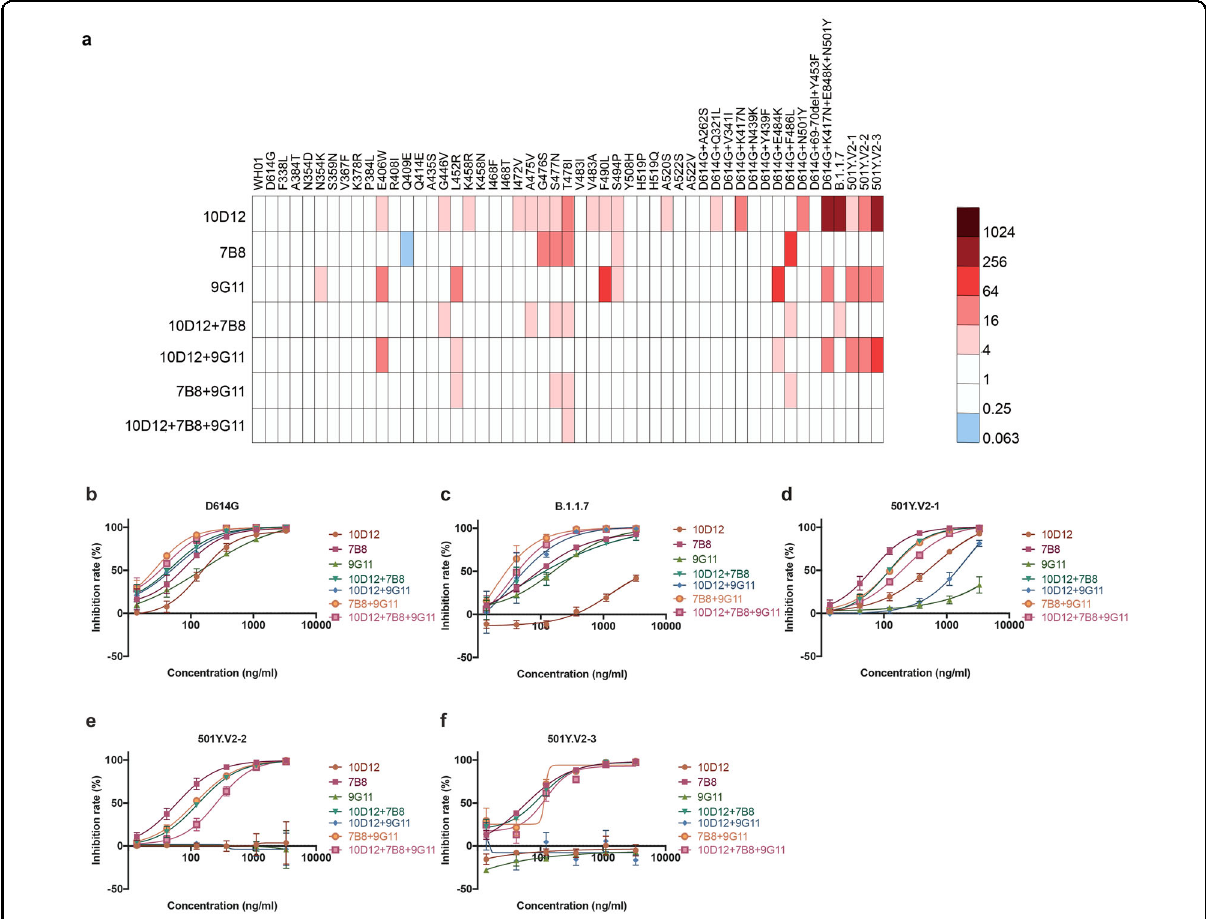
Fig. 3 Analysis of the neutralizing activity of mAbs and their combinations on SARS-CoV-2 pseudotyped viruses with mutations in RBD. a Heatmap representation of neutralization reactions using three neutralizing mAbs and four cocktails against 51 pseudotyped viruses; the ratio of EC 50 value (for each of the tested antibodies) detected for each of RBD-related mutant to the EC 50 value for the reference Wuhan-1 (WH01) variant pseudotyped viruses. Light and dark represent decreased and increased viral resistance to mAb neutralization, respectively. The mixing ratio of different antibodies was 1:1 and 1:1:1, respectively. The antibody concentration was calculated according to the total antibody concentration after mixing. b – f Resistance of D614G mutant, B.1.1.7 mutant, and three 501Y.V2 mutant pseudotyped viruses to single or mixed